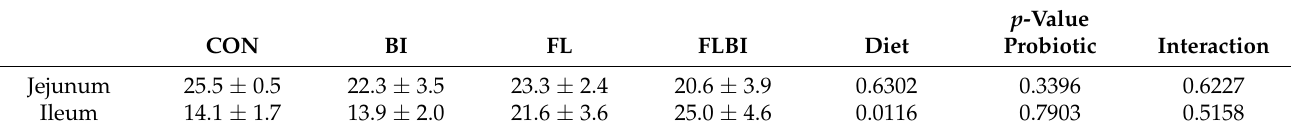
Table 3. Jejunum and Ileum Sucrase Activity.